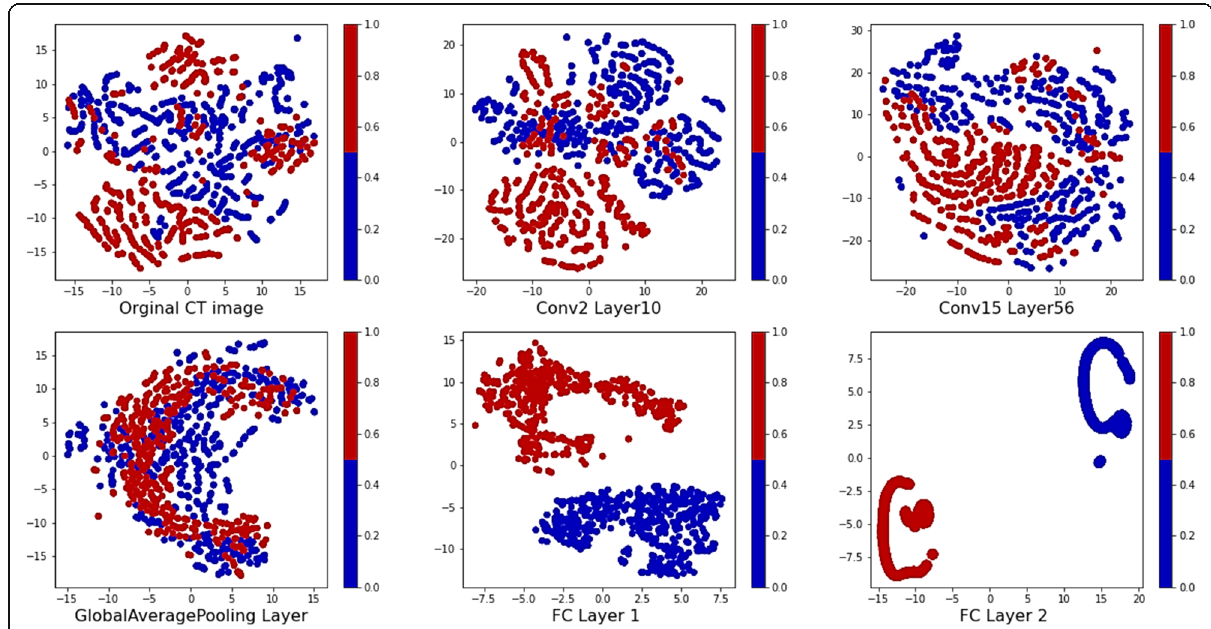
Fig. 4 Data visualizations with the t-SNE method for the DenseNet201